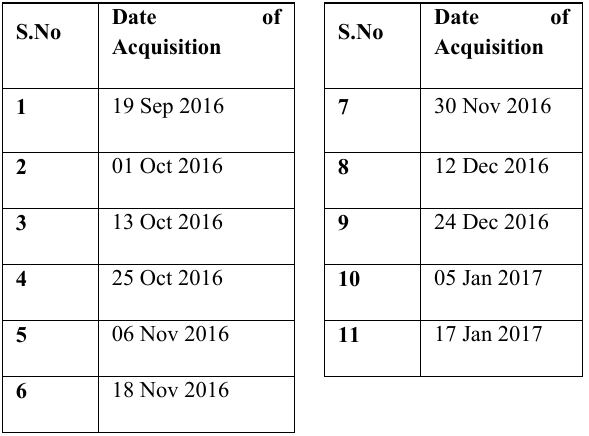
Table.3 Sentinel 1A data acquisition dates during Samba 2016 for Tiruvarur district